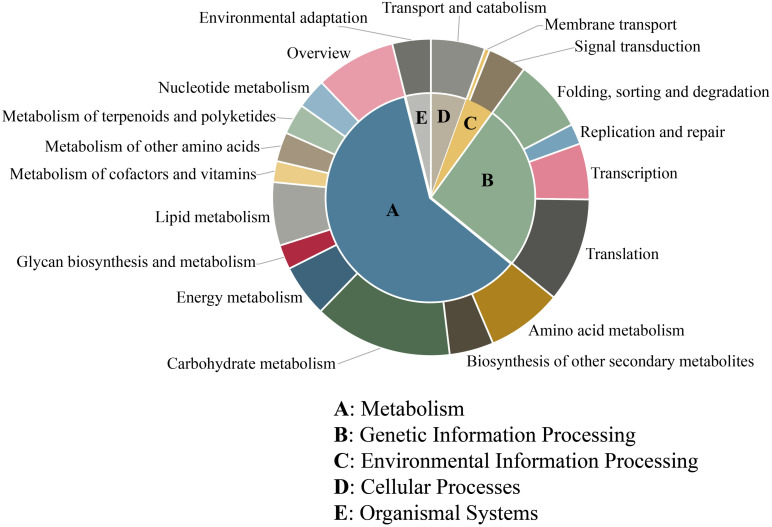
KEGG pathway classification of unigenes containing microsatellite in P. chienii transcriptome.